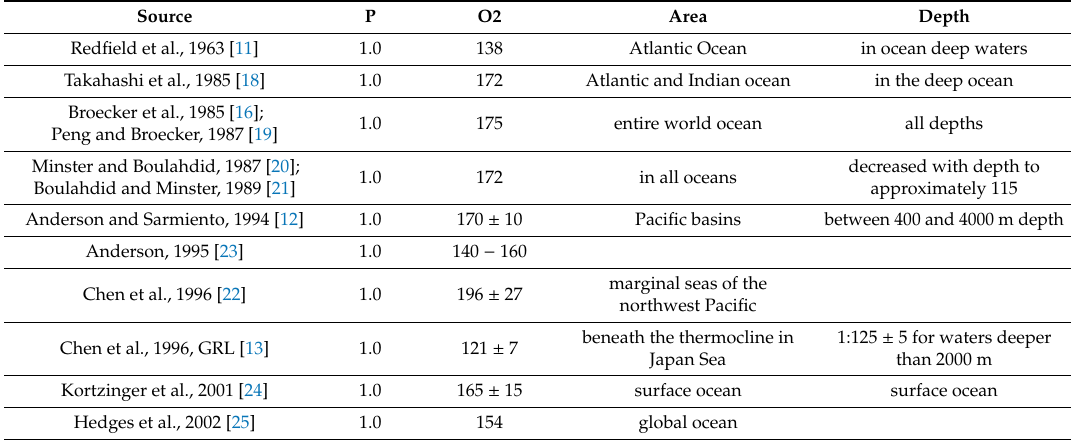
Table A2. Stoichiometric Redfield ratios for consumption of O 2 and production of P during respiration in the ocean. All values are relative to a phosphorus value of